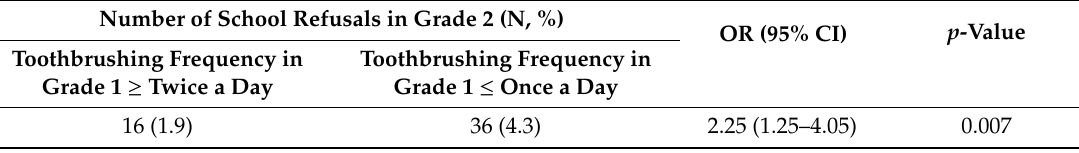
Table 3. Association of toothbrushing frequency with school refusal after propensity score matching. Number of School Refusals in Grade 2 (N,